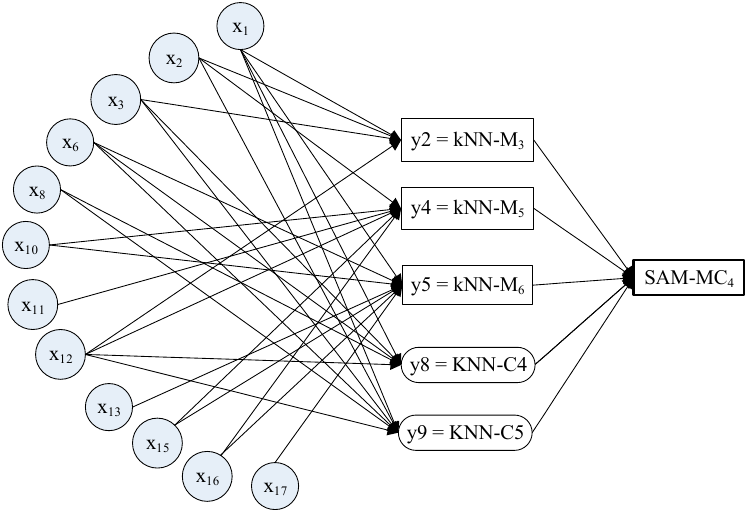
Figure 8. Structure of optimal kNN-based stacking ensemble learning model.